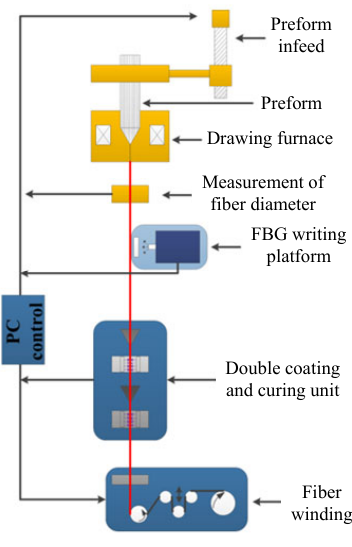
Fig. 1. Diagram of the on-line writing FBG